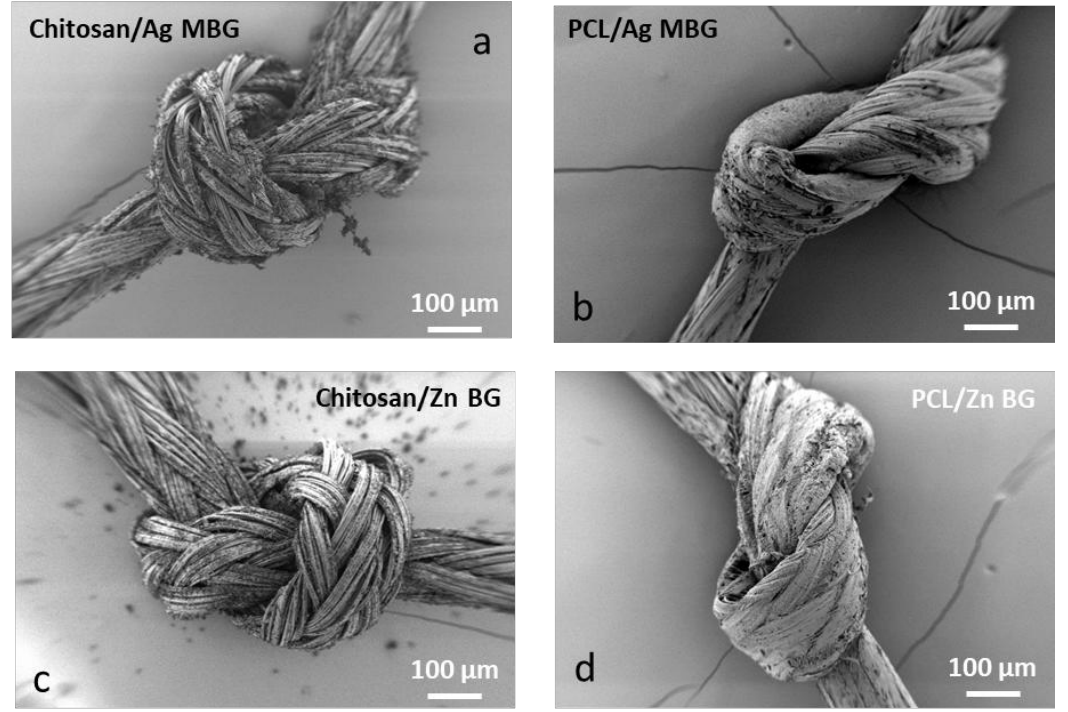
Figure 2. SEM micrographs of coated sutures after the knot test. ( a ) Chitosan/Ag-MBG, ( b ) PCL/Ag-MBG, ( c ) Chitosan/Zn-BG, and ( d ) PCL/Zn-BG.